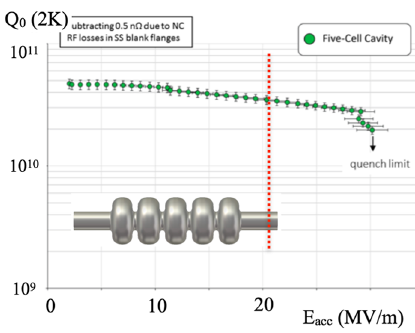
Fig. 9 ERL geometry, using two superconducting linear accelerators, connected by three-pass return arcs